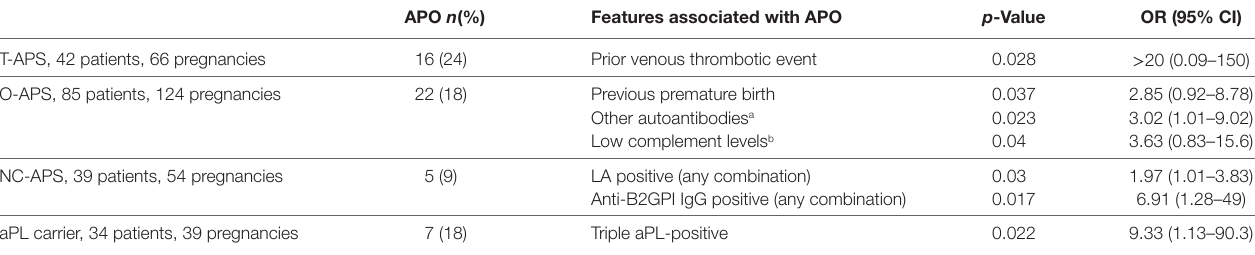
Table 7 | Laboratory and clinical features associated with adverse pregnancy outcome (APO) in the four